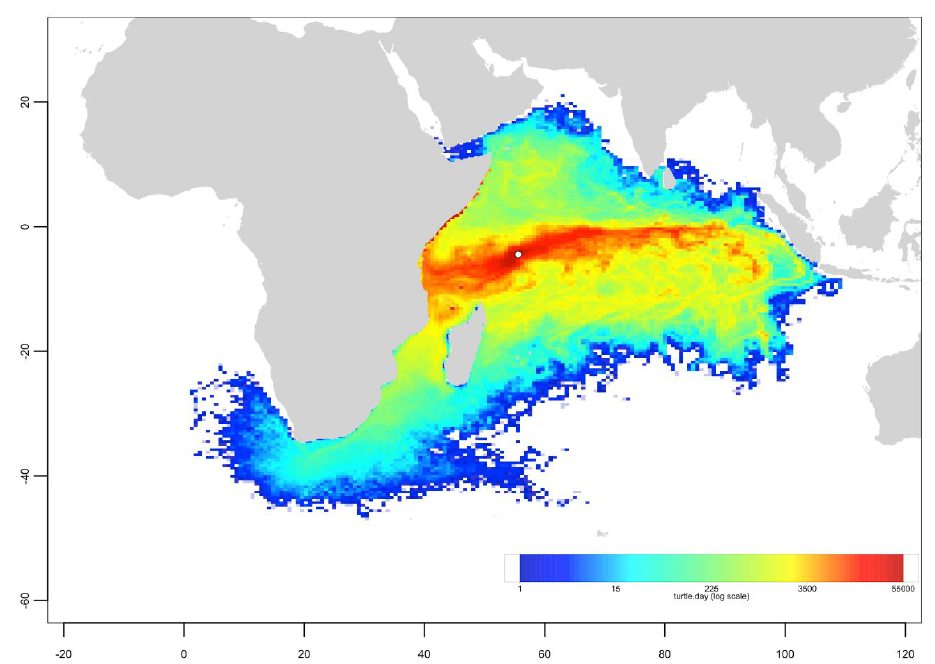
Figure A2. Granitic islands group dispersal map. One-year long trajectories of 10,000 particles released from a 0.25° × 0.25° areas central to Granitic Group (with circle) from 2002 to 2006 (for a total of 50,000 particles). The color indicates the density of particles in number of turtles per day (log scale).